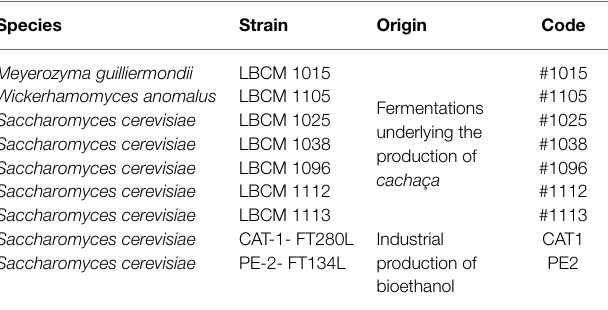
TABLE 2 | Yeast strains used in this work, their collection code, their primitive origin, and their assigned code in this work.